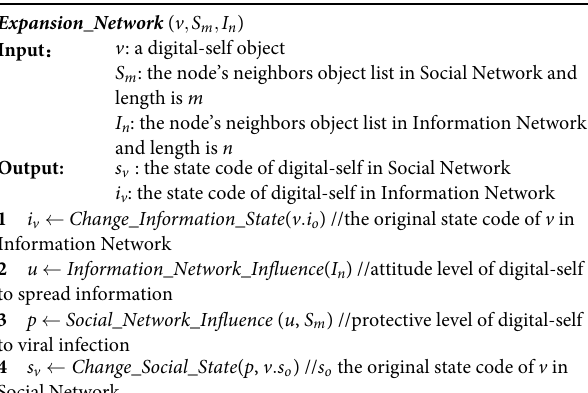
Algorithm 2 Network expansion